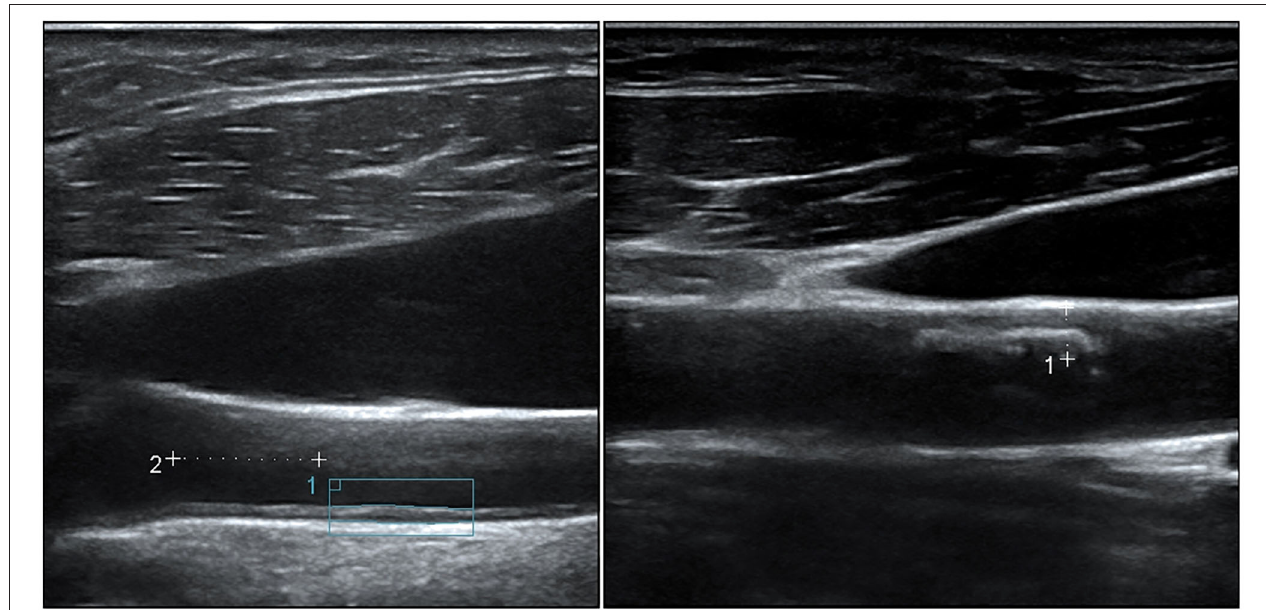
FIGURE 2 | Representative ultrasound features of carotid atherosclerosis. (Left) An increased intima-media thickness (1.048mm), measured 1cm proximal to the carotid bulb according to the Mannheim consensus. (Right) A partially calcified atheroma plaque (maximal thickness 3.1mm) at the anterior wall of the common carotid